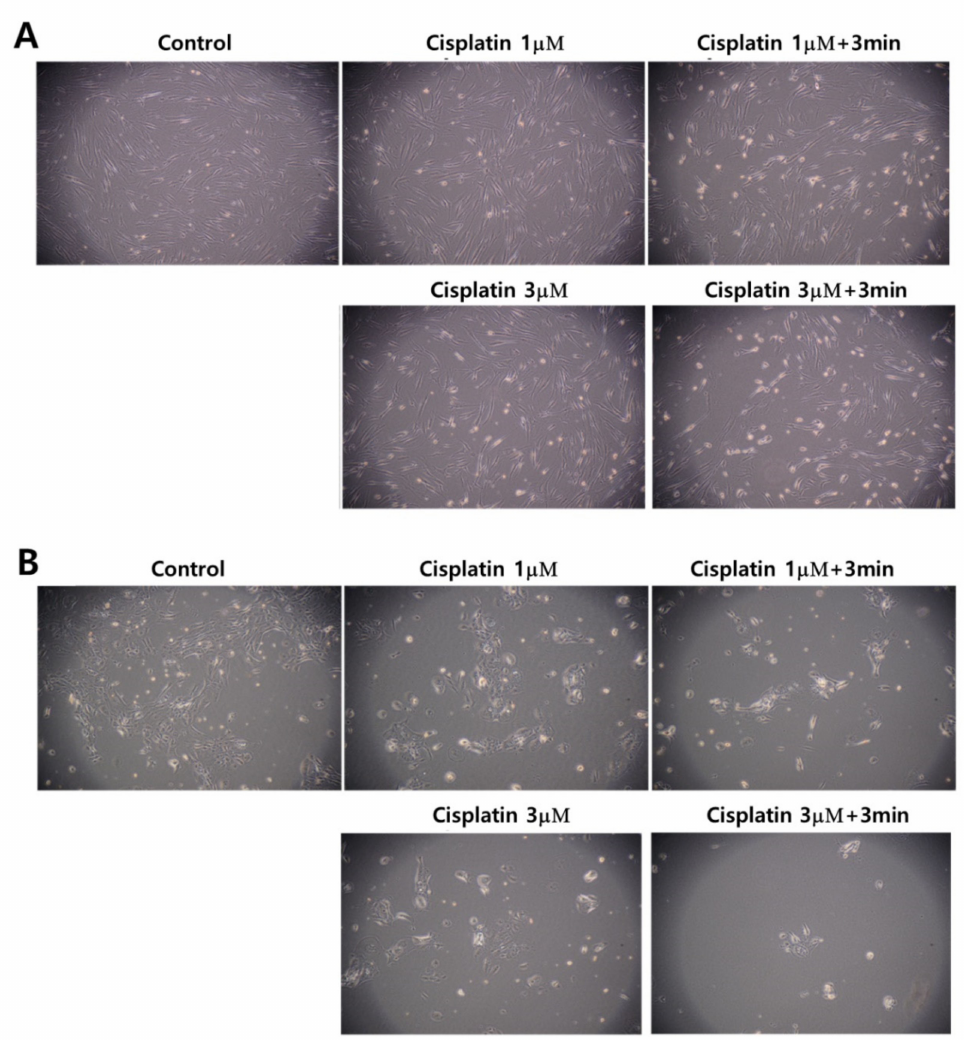
Figure 5. Observation of changes in morphology and density. ( A ) HGF-1 cells; ( B ) SCC-15 cells. The e ff ect of 1 µ M and 3 µ M cisplatin concentration with 3 min of CAP exposure. (Magnification: 100 ×